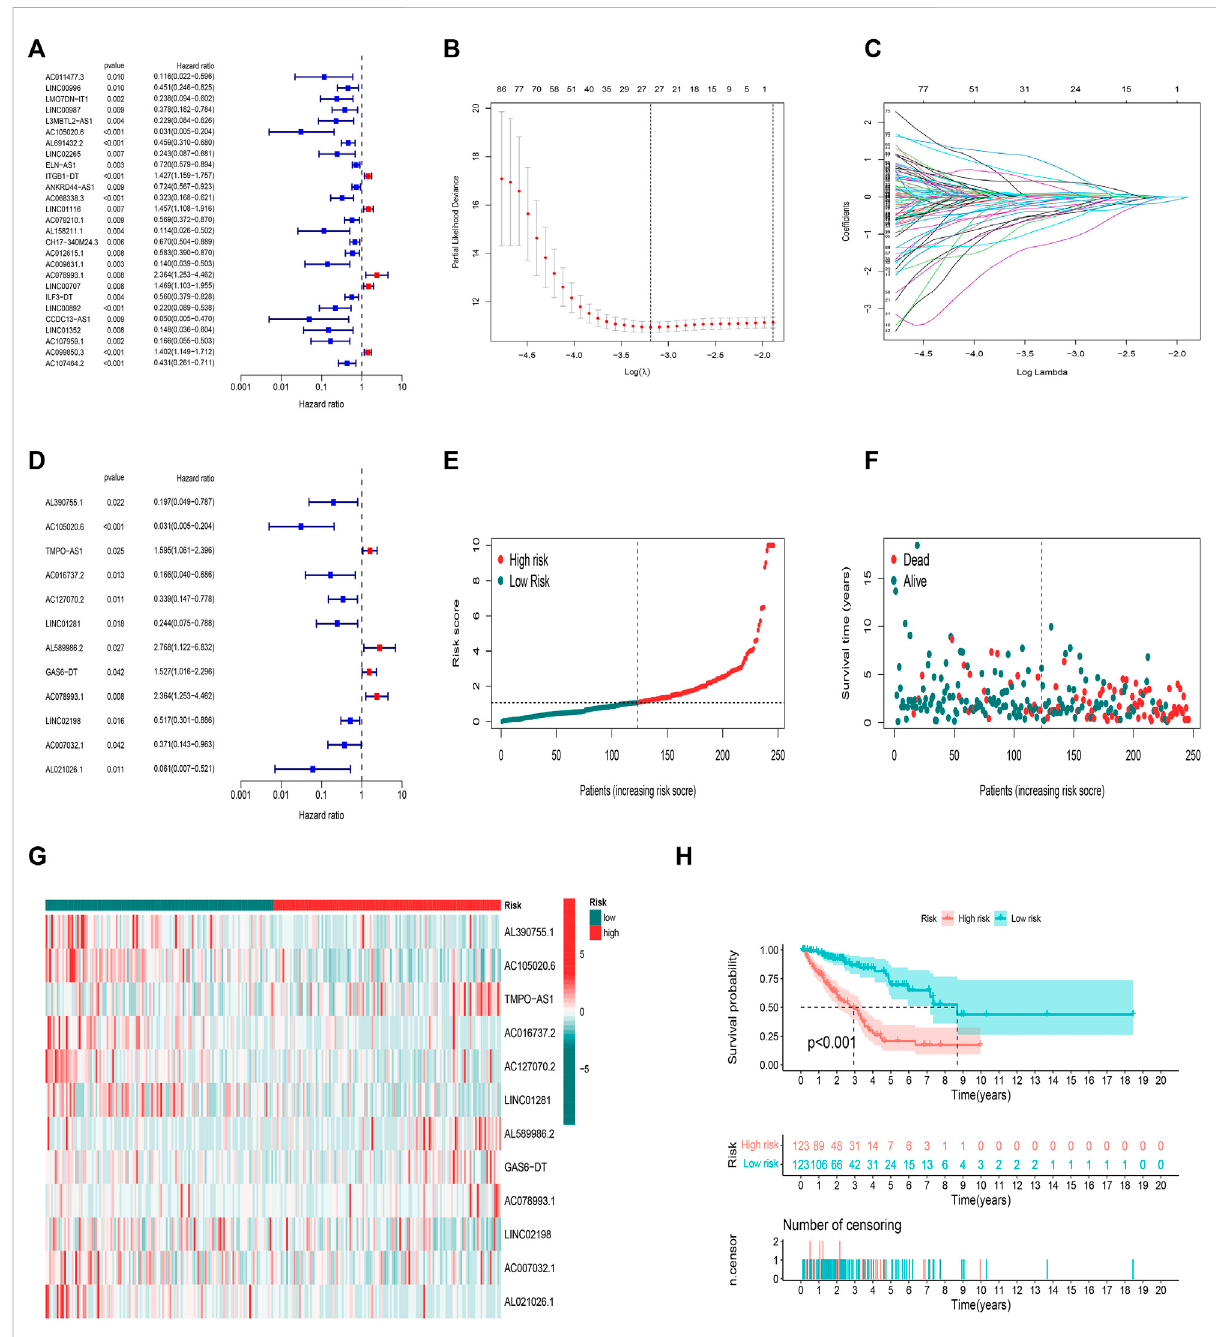
FIGURE 3 Prognostic model in training set validation. (A) Univariate Cox regression analysis. (B) The LASSO coef fi cient pro fi le. (C) The 10-fold cross- validation for variable selection in the LASSO model. (D) Multivariate Cox regression analysis and 12 lncRNAs were fi nally selected. (E) Patient risk score distribution for the training set. (F) Survival status time between two risk groups in the training set. (G) 12 FAM-related lncRNAs distributed for each patient in the training set. (H) OS curve of the training